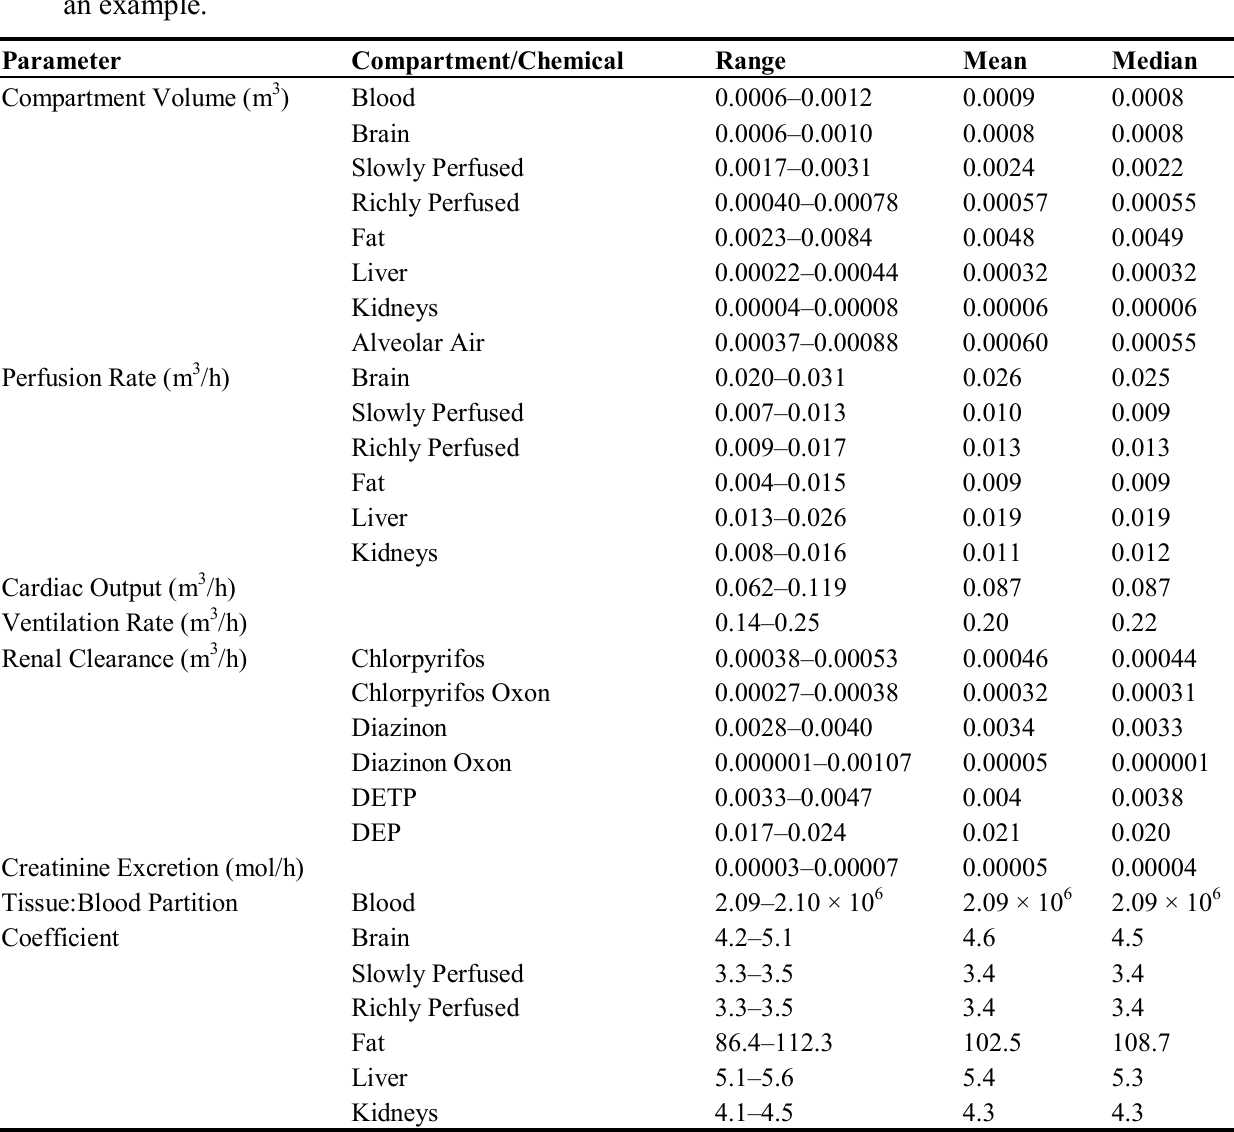
Table 3. PBPK parameters used for the child-specific model estimated using each child’s age, height and weight. Tissue: Blood partition coefficient only shown for chlorpyrifos as an